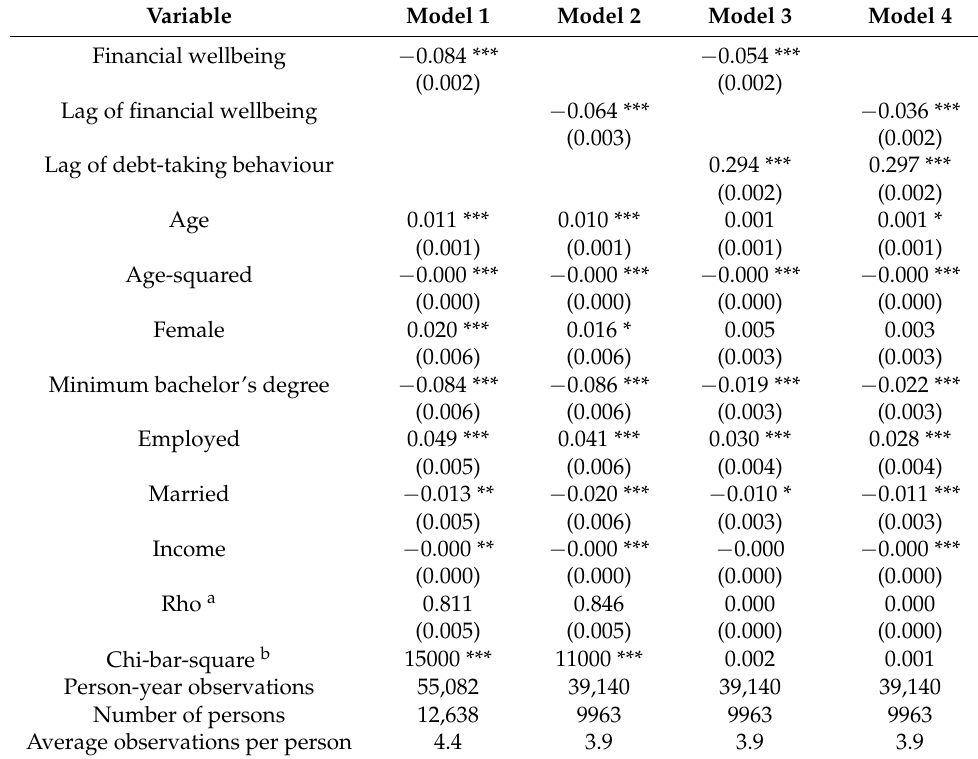
Table A2. Robustness analysis using the unbalanced